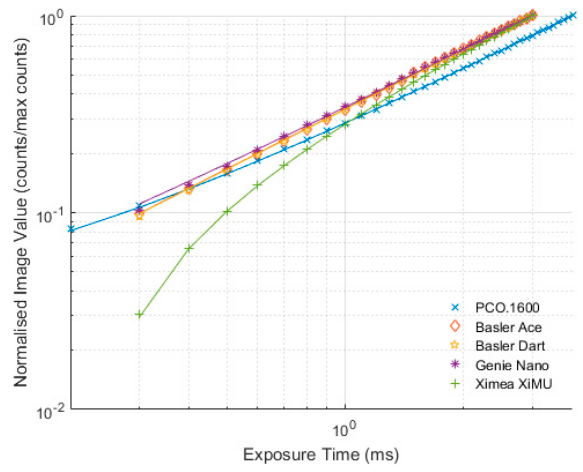
Figure 12. Normalised exposure level vs. exposure time for different cameras. Table 3. Linearity results for different cameras.